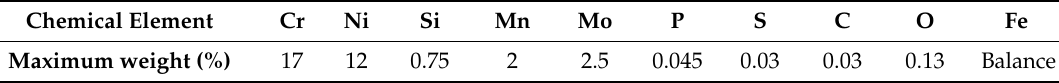
Table 1. Chemical composition of the 316L stainless steel